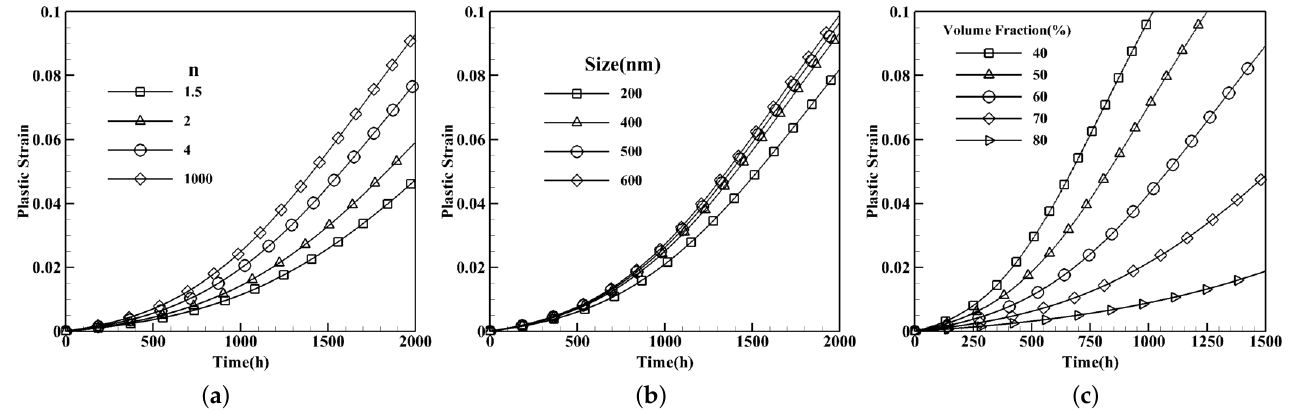
Figure 7. Creep curves for single crystals of CMSX-4 for different morphologies under 400 MPa at 850 ◦ C: Effects of ( a ) shape, ( b ) average size, and ( c ) volume